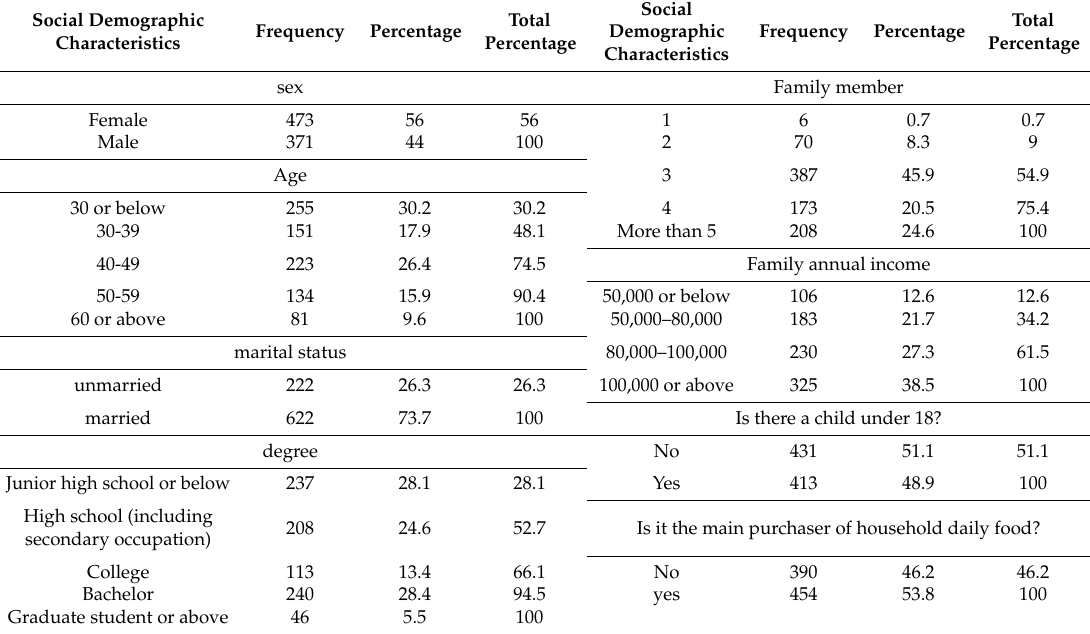
Table 1. Descriptive statistics of consumer social demographic characteristics.